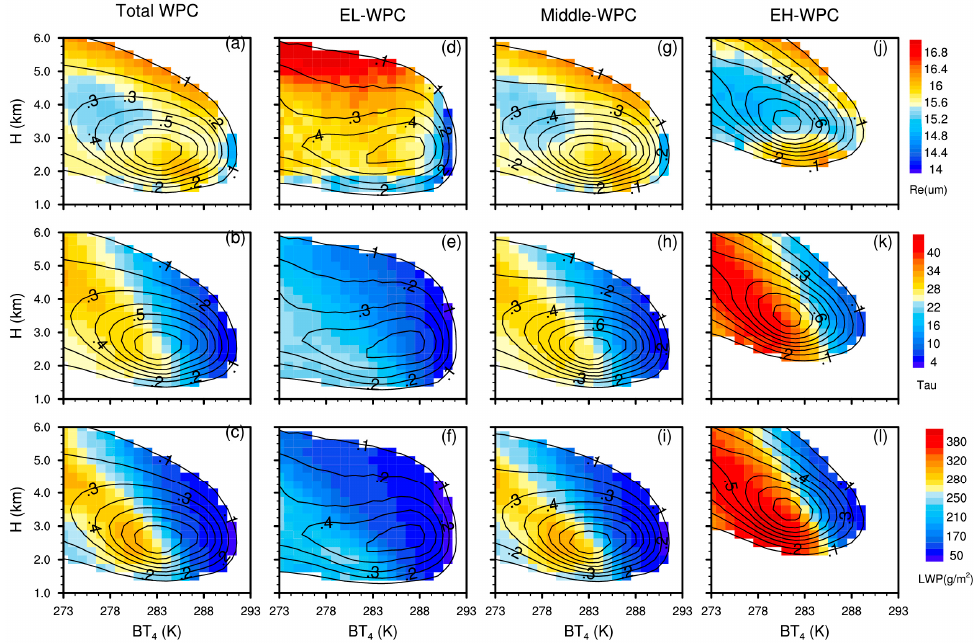
Figure 6. Distribution of mean ( top ) cloud effective radius, ( middle ) cloud optical depth, and ( bottom ) liquid water path in a two-dimensional diagram of BT 4 (brightness temperature at 10.8 μ m; x-axis) and H (echo-top height; y-axis), for ( a – c ) total-WPC, ( d – f ) EL-WPC, ( g – i ) medium, and ( j – l ) EH-WPC (colored), overlapped with their joint probability density functions of BT 4 and H (contours).